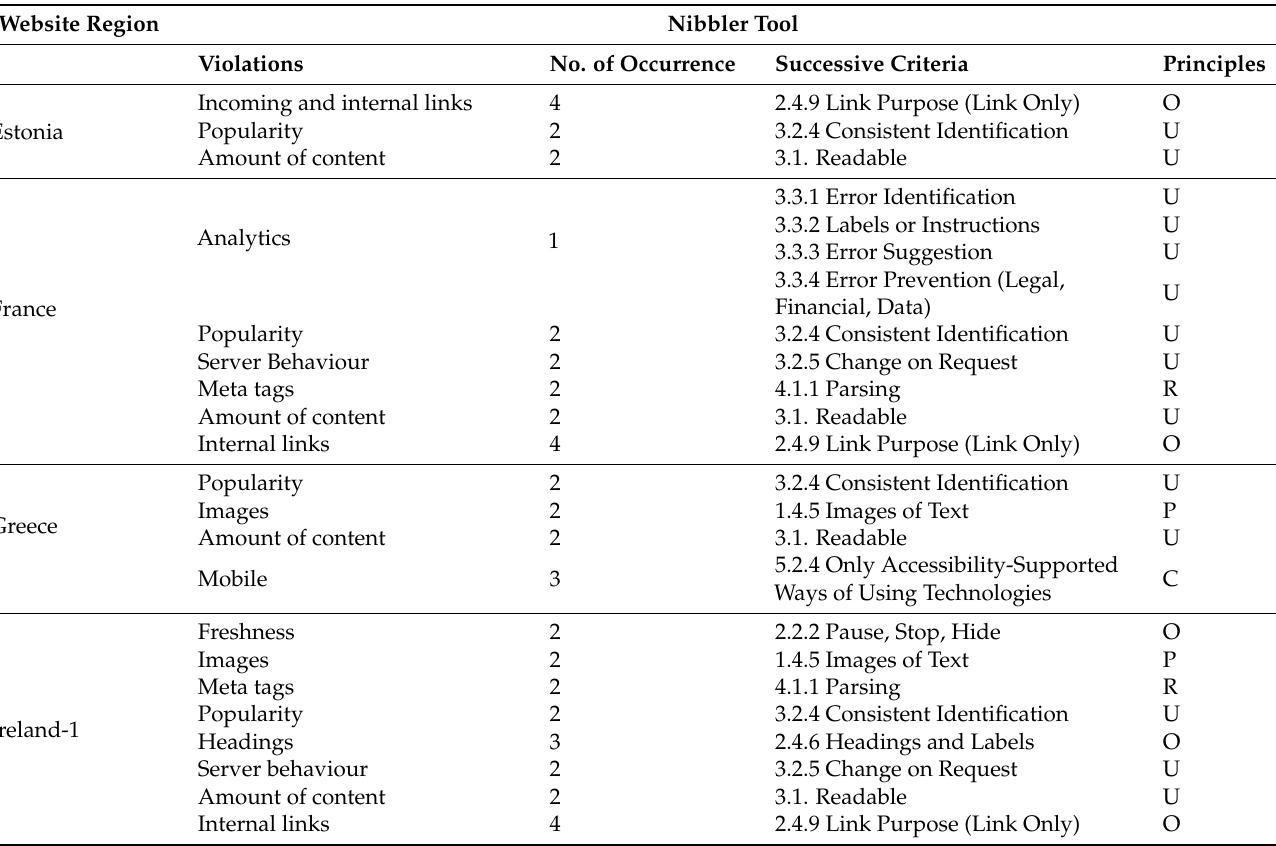
Table A3. Accessibility issues in the website of each country by